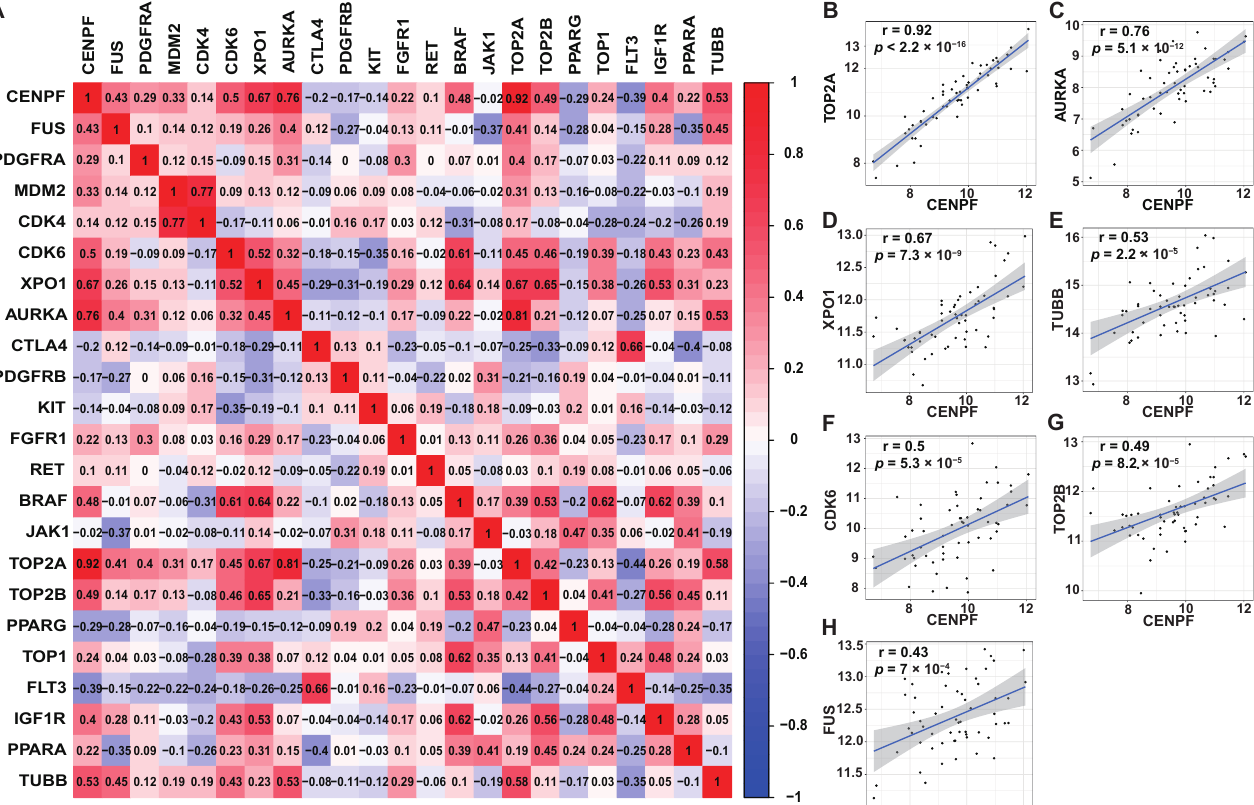
immune cells in TME of LPS. ( C , D ) Comparison of the abundance of infiltrating immune cells between CENPF high-expression and low-expression subgroup. Analysis of immune score in TME of LPS tissues: ( E ) the correlation between CENPF expression and immune score. ( F ) KM curve of OS for DDLPS patients categorized by the immune score (high vs. low) with the number of censored patients at each timepoint (numbers at risk) listed under it. The optimal cut-off of survival curves was determined by X-tile [34]. ( G ) Correlation analysis between CENPF expression and scores of immune cells with correlation coefficient marked on the matrix plot. Positive and negative correlations were indicated by red and blue boxes, respectively. Color intensity and absolute value of correlation coefficient were directly proportional to the correlation strength. OS: overall survival; DDLPS: dedifferentiated liposarcoma.